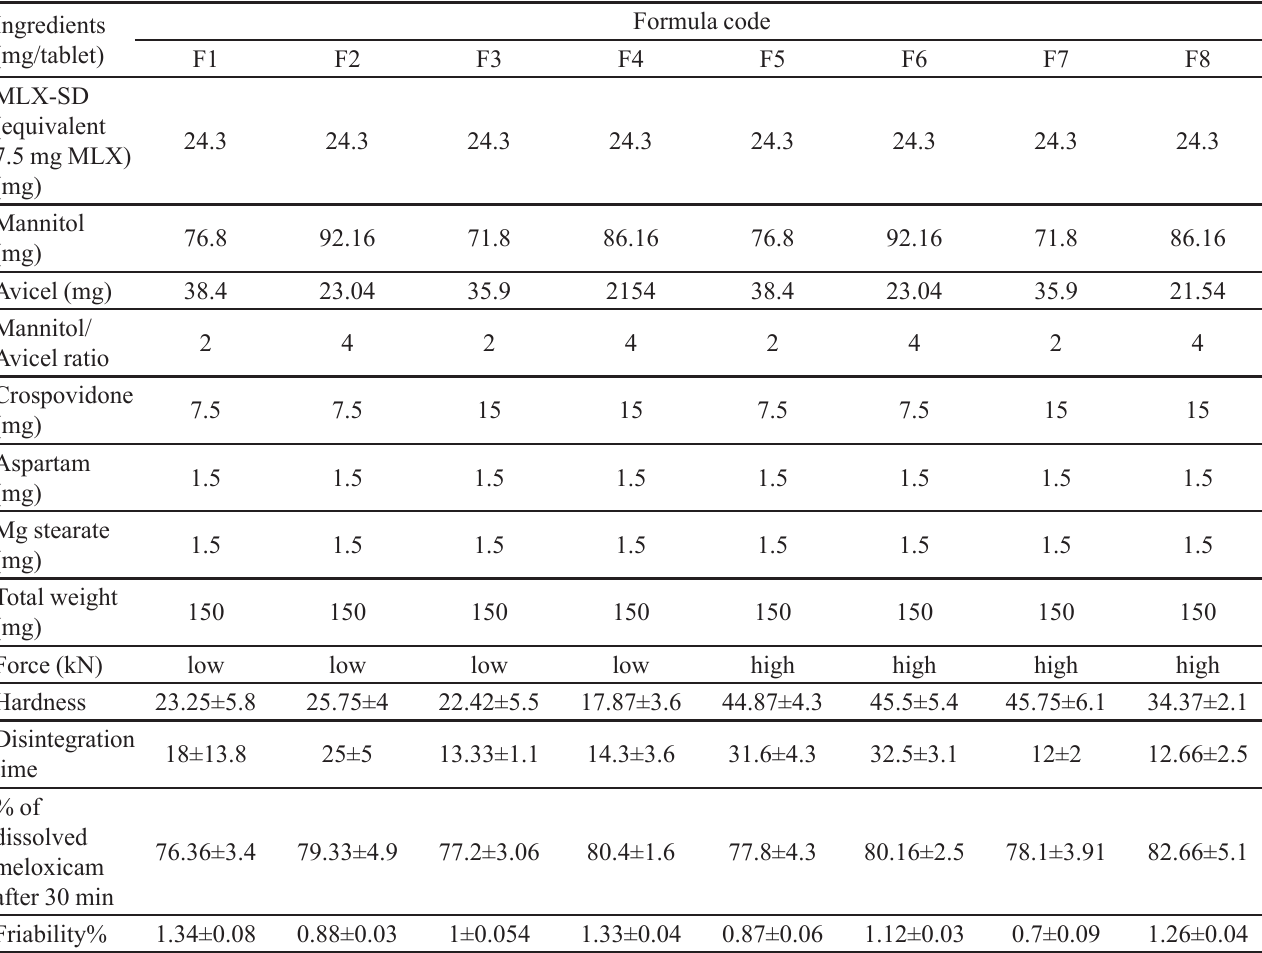
TABLE III - Factorial design of MLX ODTs (F1 to F8) and the response parameters